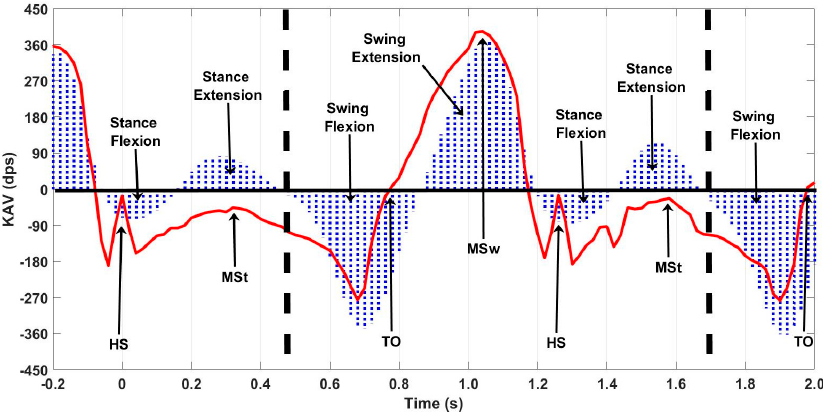
Figure 4. Swing and stance flexion intervals in the Vicon KAV. Zero-crossing in the Vicon KAV signal prior to swing flexion was used to delimit strides by the dashed lines. This zero-crossing was always found between MSt and TO. Blue area, Vicon KAV signal; Red line, MAPR SAV used to identify HS, MSt, and TO. HS, Heel-Strike; MSt, Mid-stance; TO, Toe-Off; MSw, Mid-swing; KAV, Knee Angular Velocity; dps, degrees per second.